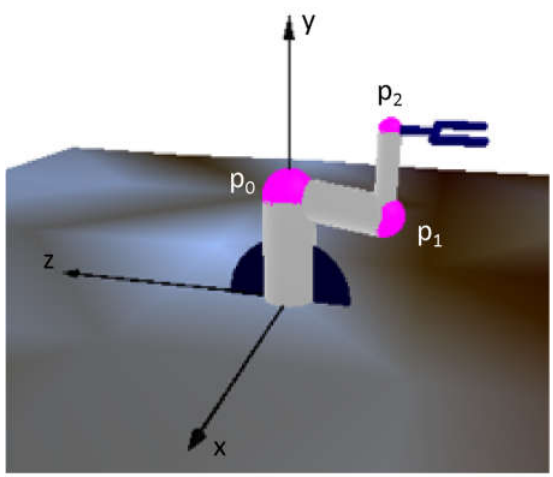
Figure 4. The human-arm-like kinematics